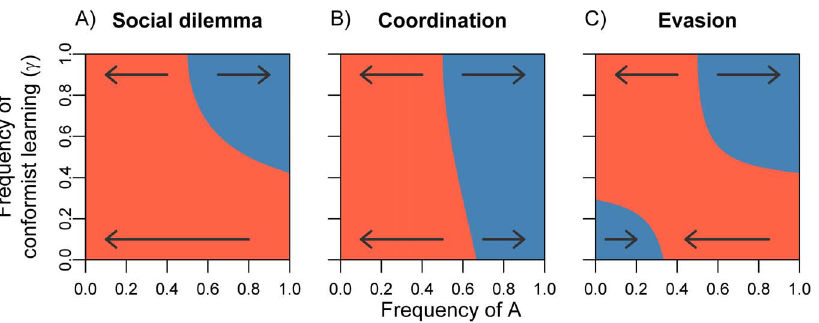
Figure 1. Effect of conformism on the dynamics of cultural evolution when conformism-based learning is represented by a coordination game. In three interaction contexts (social dilemma, coordination game, evasion game), colours and arrows indicate the expected change in the frequency of behavioural strategy A for a given value of c , the relative frequency of conformism-based learning. In blue regions (arrows to the right), A tends to increase; in red regions (arrows to the left), A tends to decrease. When all learning is conformism-based ( c =1), cultural evolution will either lead to the fixation of A or to the fixation of B , depending on which strategy was initially most frequent in the population. When all learning is payoff-based ( c =0), strategy A (‘cooperation’) will disappear in the social dilemma; either A or B will go to fixation in the coordination game; and A and B will stably coexist in the evasion game. Changing c from 0 to 1 leads to a smooth transition between these two